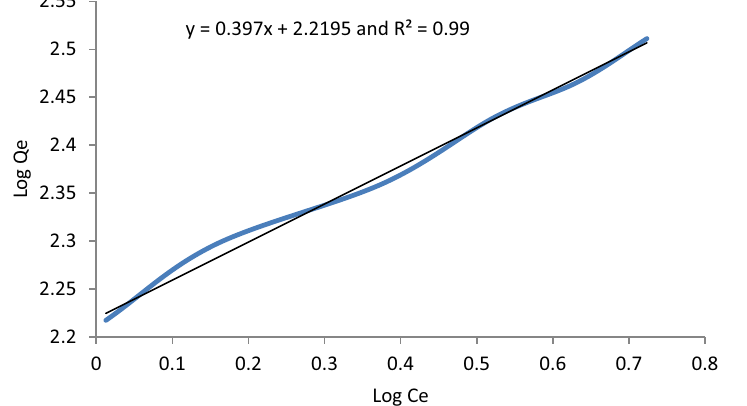
Figure 11. Freundlich isotherm graphical representation.